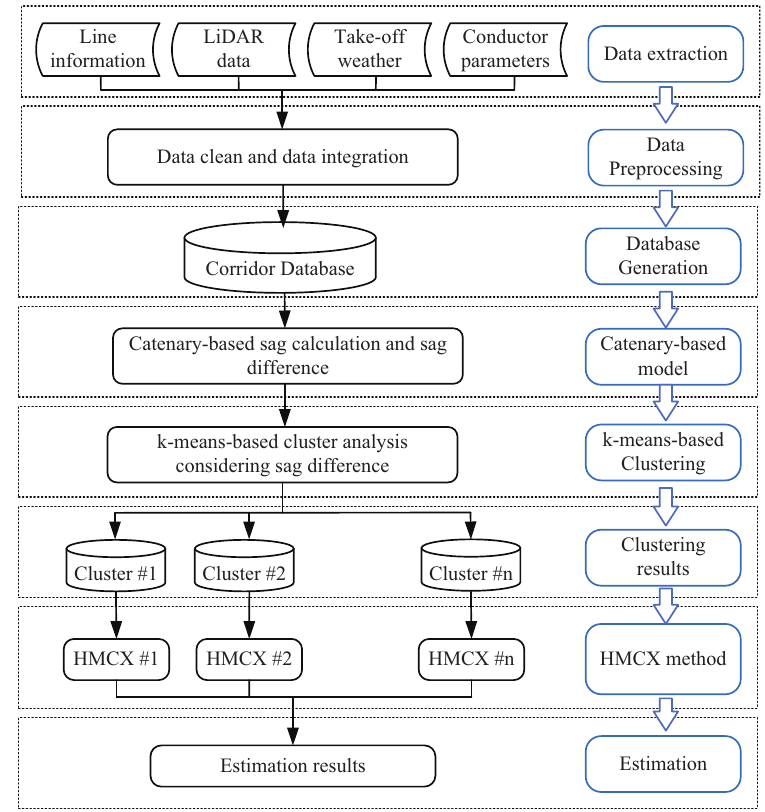
Figure 2. Program flow chart of HMCX construction.